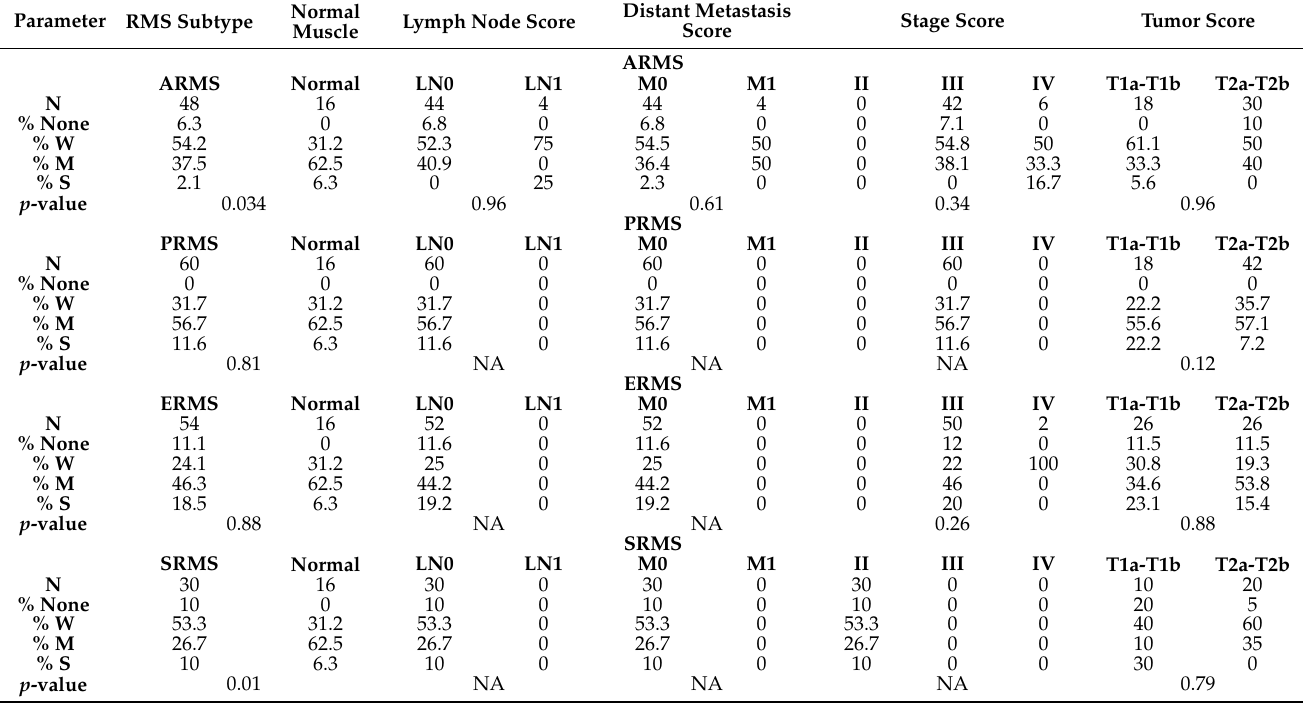
Table 4. Correlation of Cytosolic XBP1 protein expression with the clinicopathological features of RMS